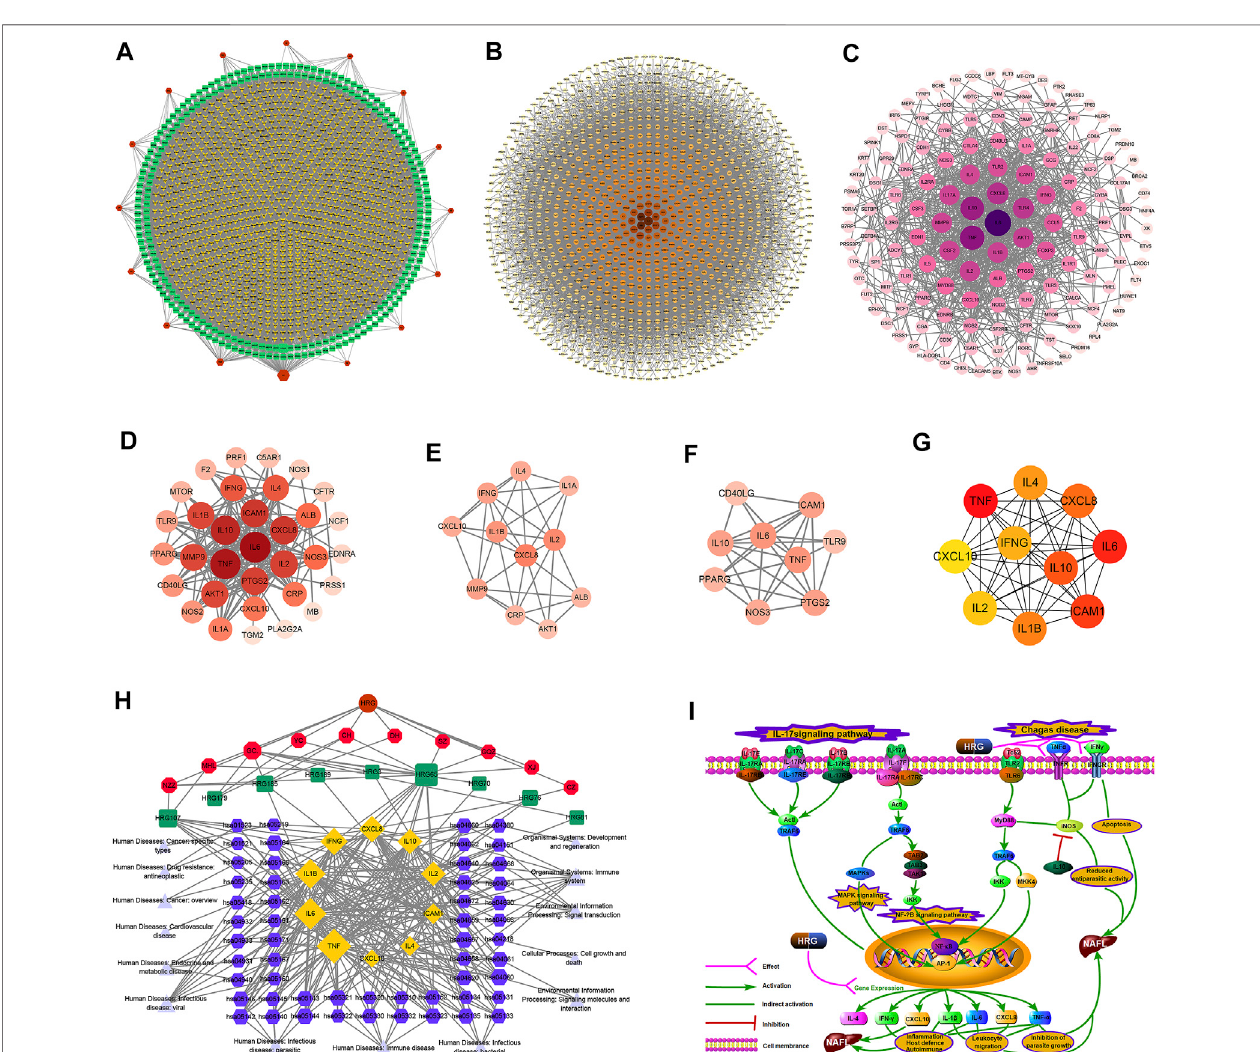
FIGURE4| Network construction and correlation analysis.[ (A) Herb-compound-target networkofHRG. (B) PPInetworkrelated toNAFL. (C) PPInetwork related to IFD. (D) PPI network of HRG-IFD-NAFL merge targets. (E) Module 1. (F) Module 2. (G) Hub gene. (H) Herb-key compound-potential target-pathway network. (I) Illustration of crucial putative biological progress caused by key